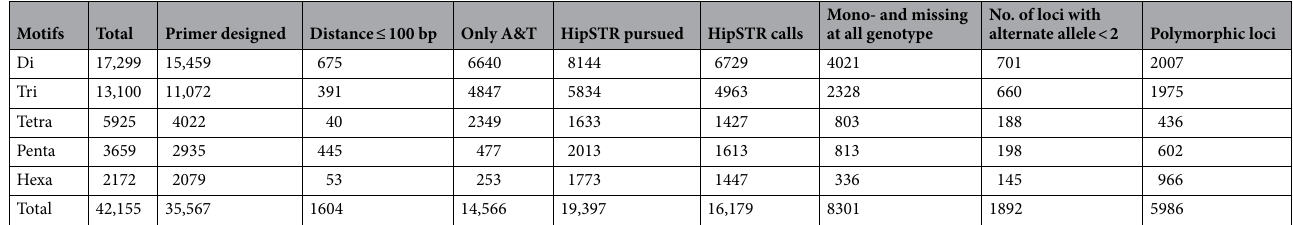
Table 2. Distribution of simple sequence repeat (SSR) marker in Sp75 genome. Stepwise screening of genome- wide SSR loci to develop polymorphic SSRs is noted. Selected SSR loci were computationally genotyped using the genome sequences of additional accessions. The SSR loci varying in repeating units among the 21 spinach accessions were identified as a polymorphic marker.